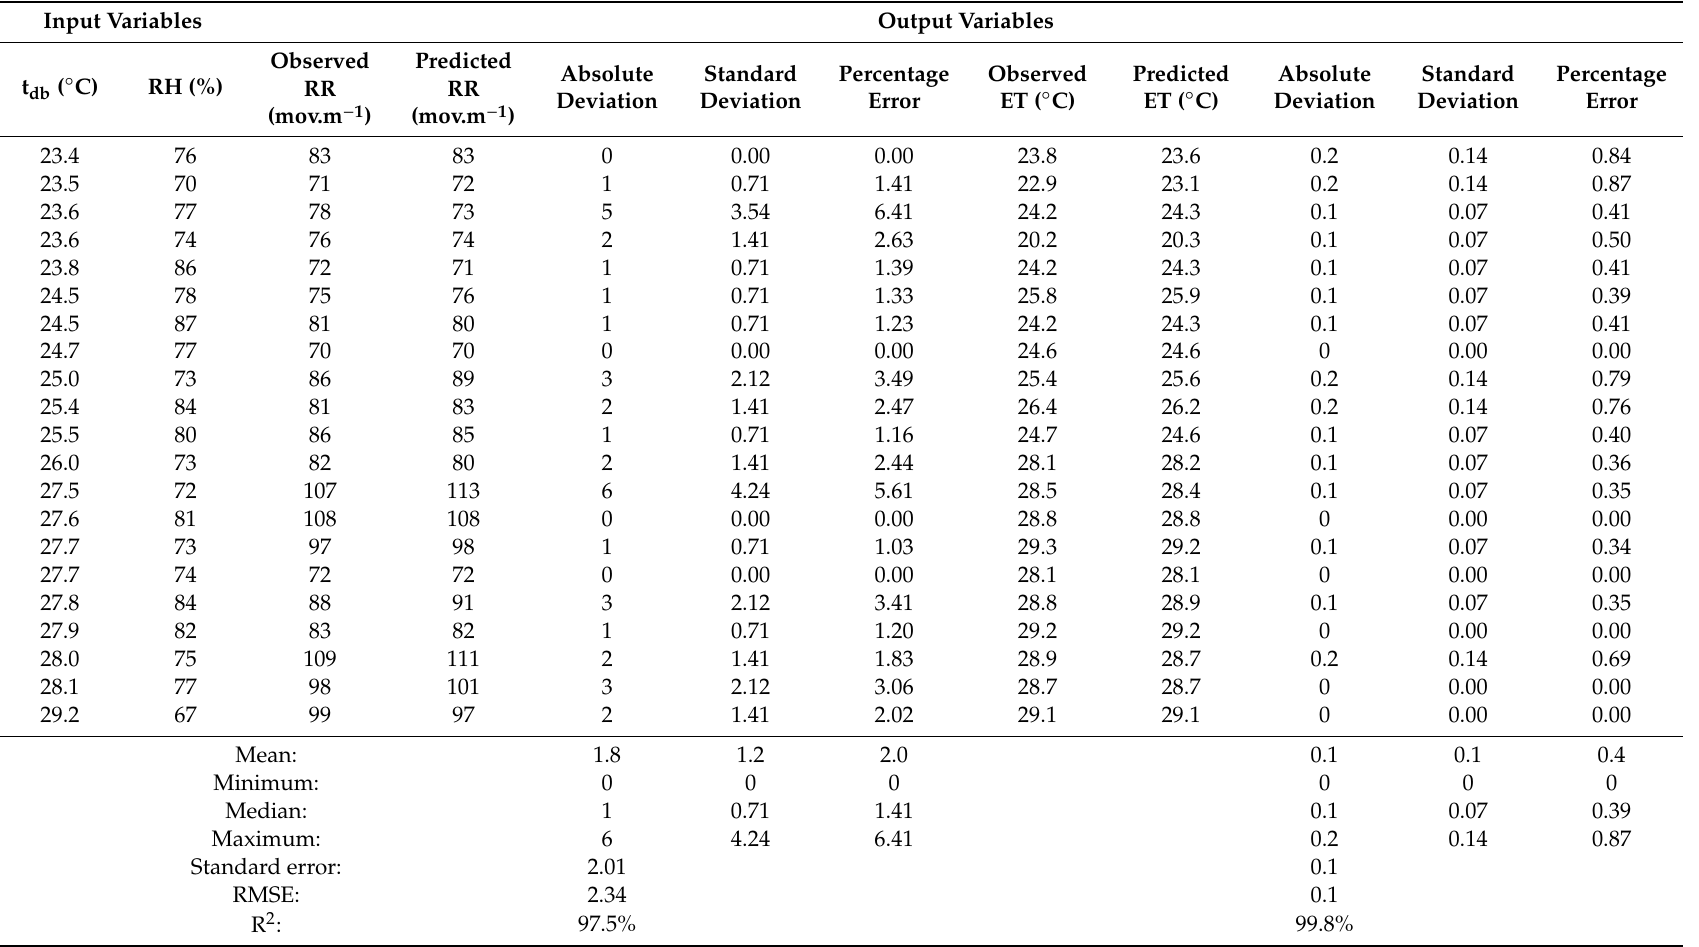
Table 4. Statistical indices for test results for the decision tree